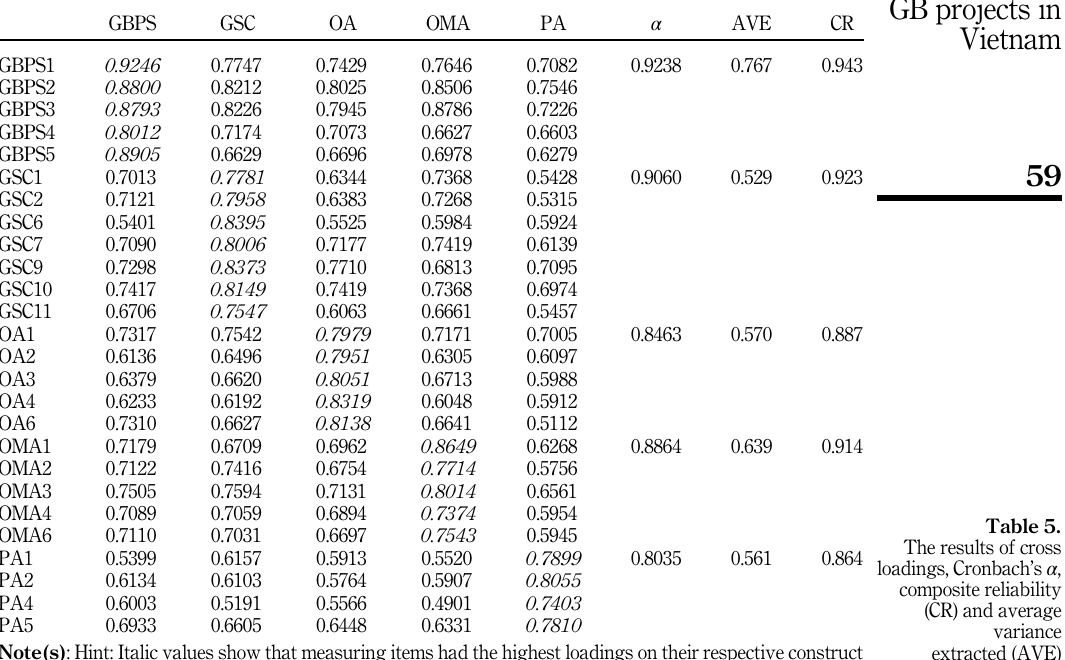
Table 5. The results of cross